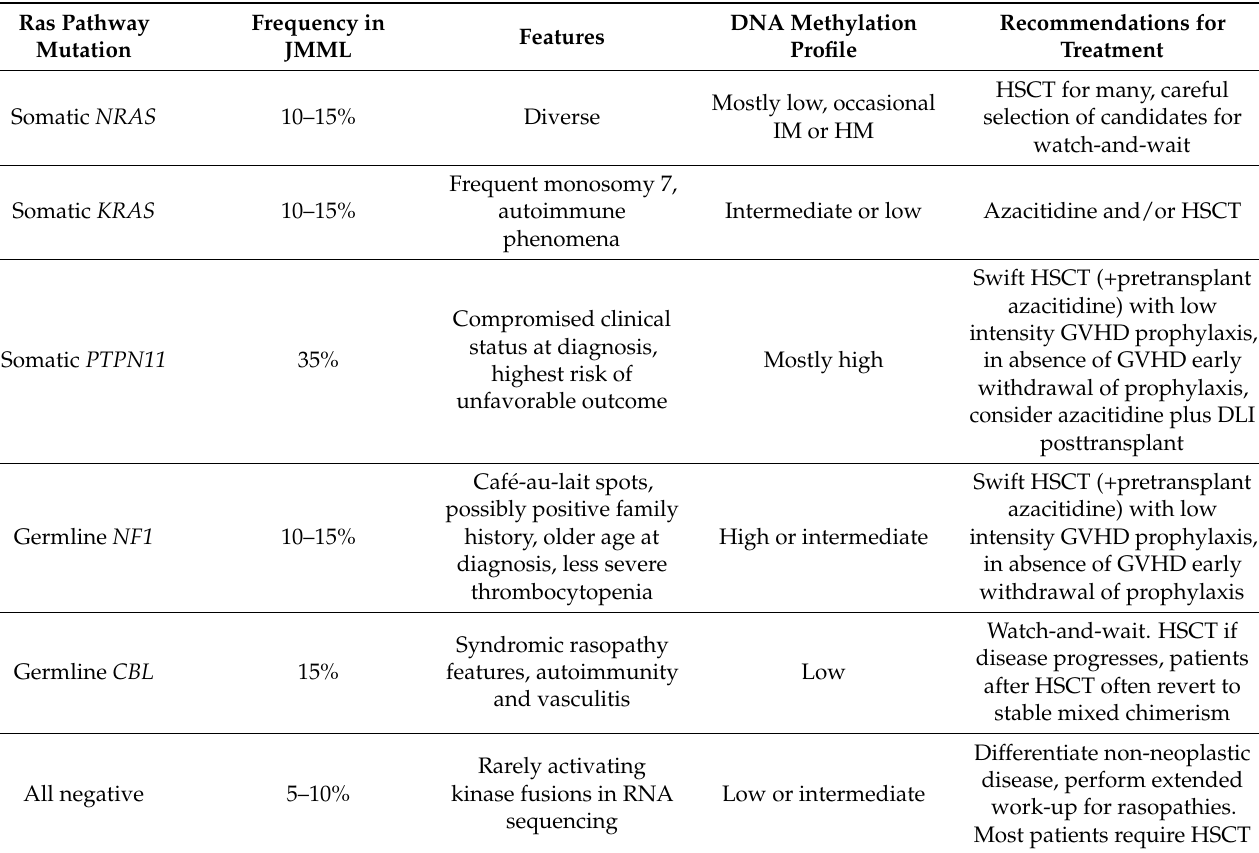
Table 1. Management of JMML according to driver mutation. HSCT, hematopoietic stem cell transplantation; GVHD, graft-versus-host disease; DLI, donor lymphocyte infusions; NF-1, neurofibromatosis 1. Ras